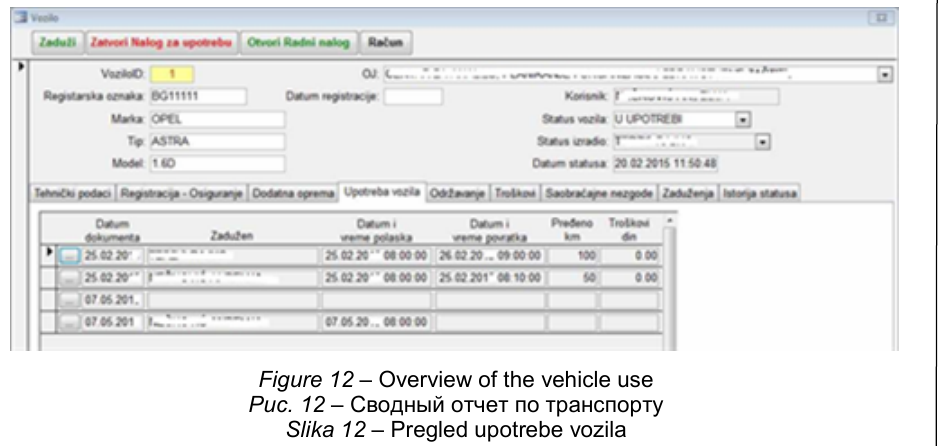
Figure 12 – Overview of the vehicle use Рис . 12 – Сводный отчет по транспорту Slika 12 – Pregled upotrebe vozila This display form can quickly show the data on the use of vehicles, the mileage and expenses incurred during the use of vehicles.